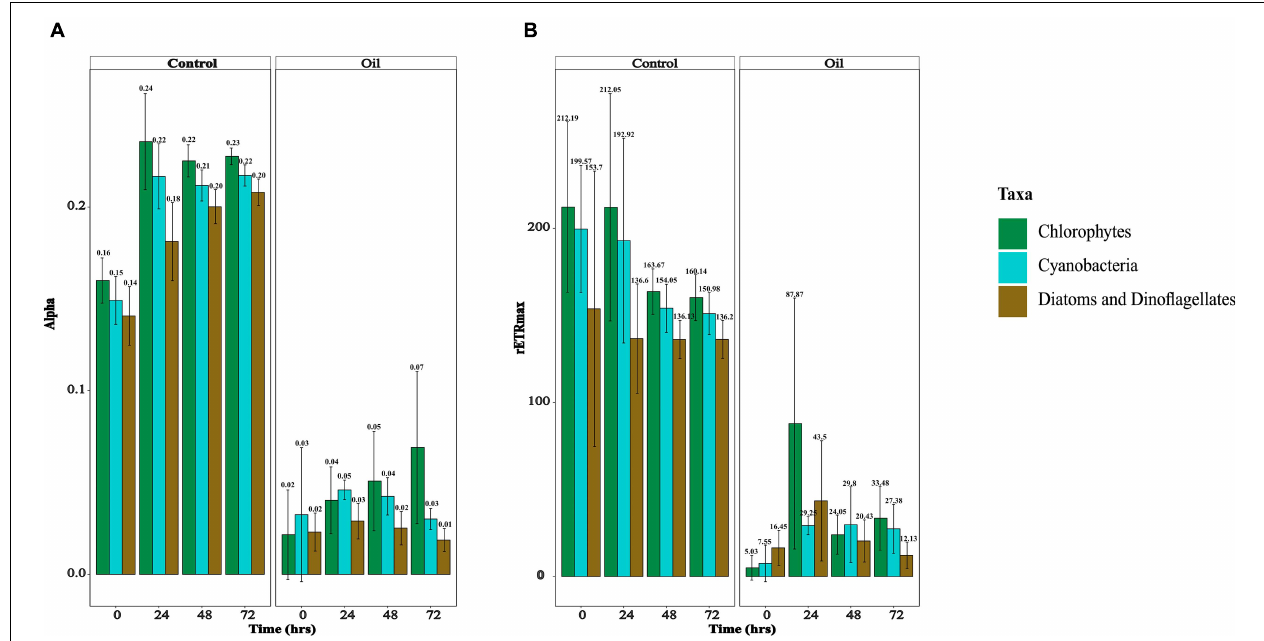
FIGURE 2 | Photosynthetic physiology of different classes of phytoplankton. (A) Alpha/light harvesting ability ( µ mol e – · µ mol photons − 1 ) in the long-term experiment and (B) relative electron transport rates ( µ mol e – · m – 2 · s – 1 ) in the long-term